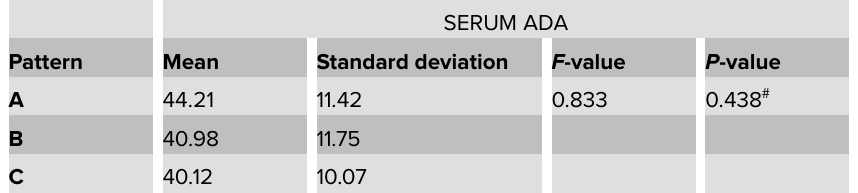
TABLE 3: Correlation of serum ADA levels with different cytological patterns of tubercular lymphadenitis (Department of Pathology, TMU from January 2019 to June 2020) n =